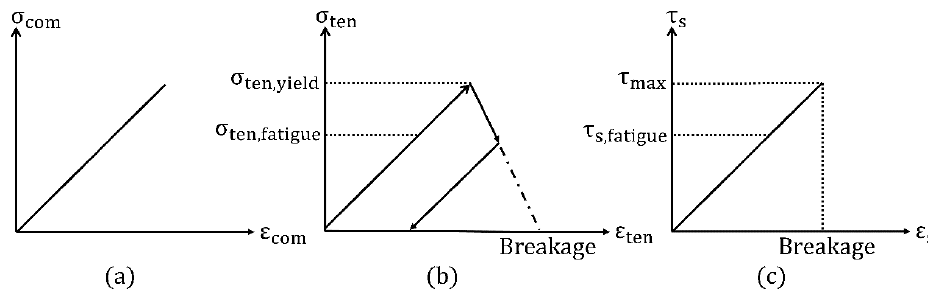
Figure 7. Bond response in different load modes: ( a ) Compression; ( b ) Tension; ( c ) Shear.